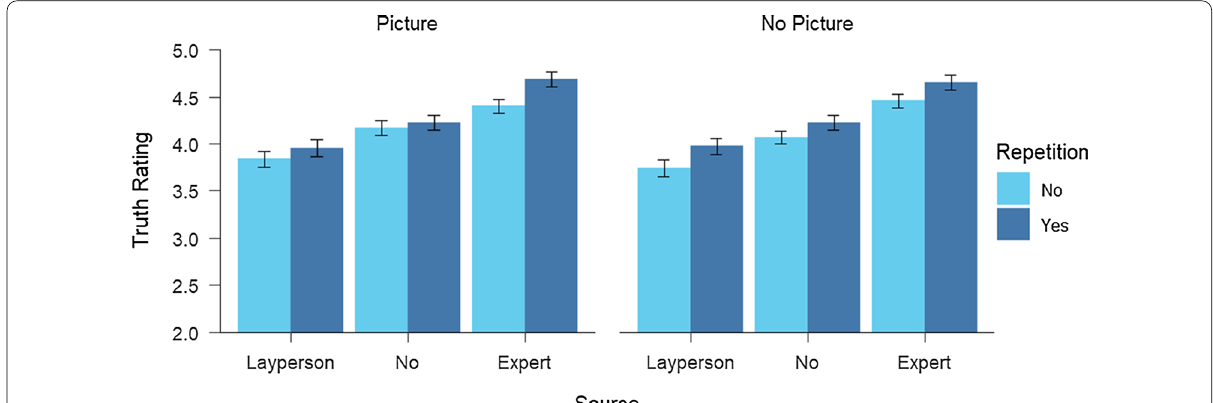
Fig. 2 Mean truth ratings in Experiment 2 as a function of picture, source, and repetition conditions. Error bars represent standard error of the